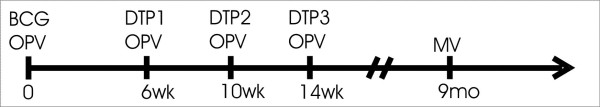
Vaccine schedule in Guinea-Bissau. Consisting of BCG vaccine, oral polio vaccine (OPV), diphtheria-tetanus-pertussis (DTP), and measles vaccine (MV). In September 2008 DTP was exchanged for diphtheria-tetanus-pertussis-Hepatitis B-H. Influenzae (Pentavalent) vaccine and yellow fever vaccine was introduced to be given together with MV. wk: weeks, mo: months.